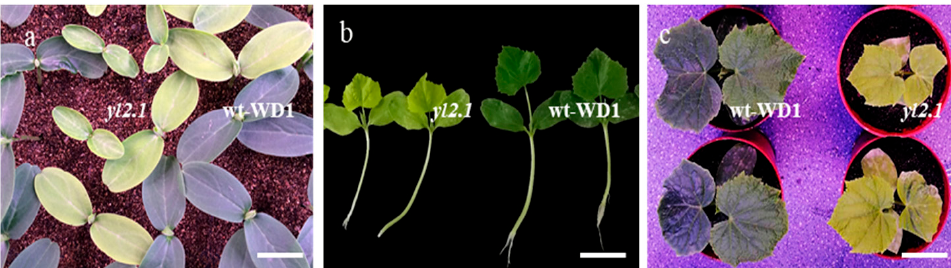
Figure 1. Phenotypical characterization of yl2.1 and wt-WD1. Cotyledon color of the yl2.1 and wt-WD1 ( a ); true leaf color of yl2.1 and wt-WD1 at the first true leaf stage ( b ) and the two fully unfolded true leaves stage ( c ). Scale bar = 2 cm.